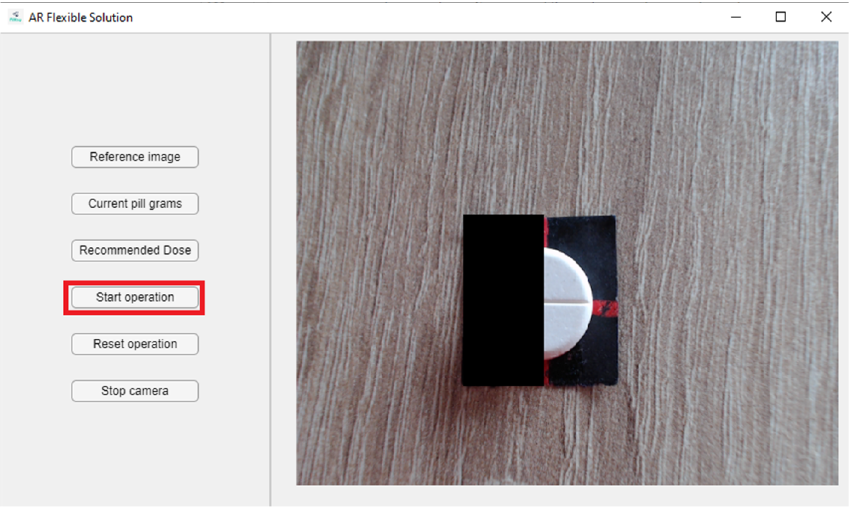
Figure 9. Capture of a reference image that may be divided.